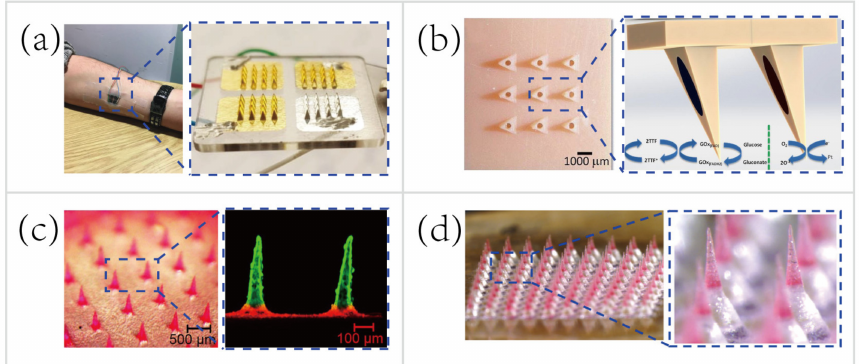
Figure 11. Representative applications of microneedles (MNs) for transdermal biosensing and pain-free drug delivery. ( a ) MN-based biosensor for continuous monitoring of β -lactam antibiotic concentration in vivo [83]. Copyright 2019, American Chemical Society. ( b ) MN-based self-powered glucose sensor and schematic reaction on two of the hollow MNs located within the MNs array [37]. Copyright 2014, Elsevier. ( c ) Multilayered pyramidal dissolving MNs, composed of silk fibroin tips supported on flexible pedestals, for improving drug delivery [38]. Copyright 2017, Elsevier. ( d ) MN patch with drug-loaded tips and e ff ervescent backings for long-acting reversible contraception [40]. Copyright 2019, American Association for the Advancement of